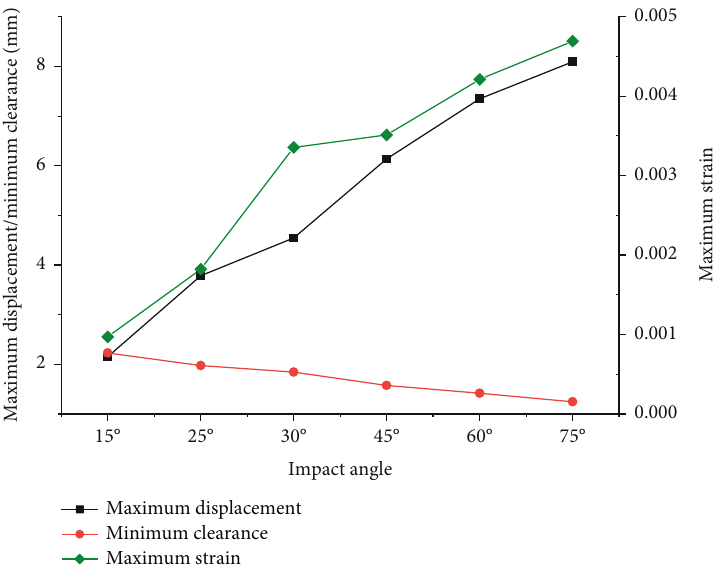
Figure 24: Maximum displacement, minimum gap, and maximum strain of the battery box at di ff erent impact